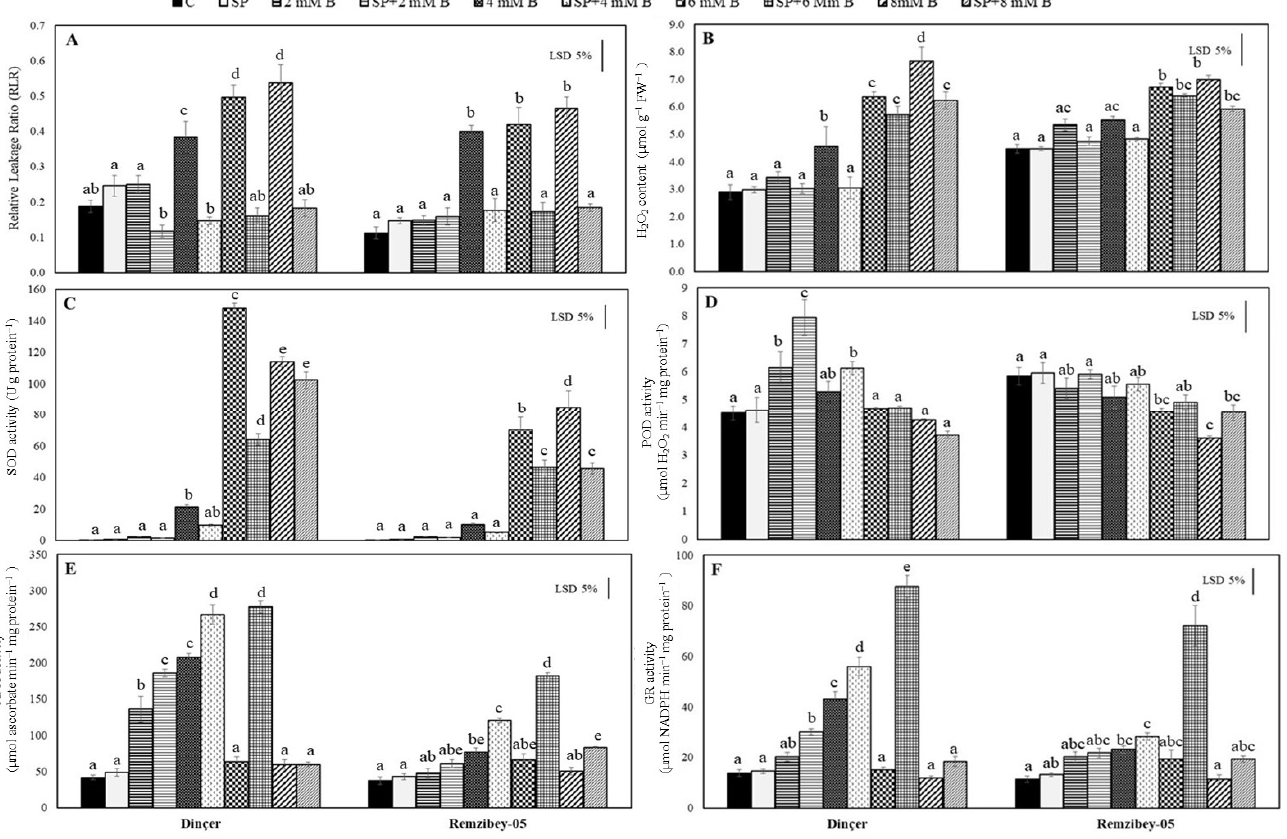
Figure 6. B treatments with or without SP induced changes of RLR ( A ), H 2 O 2 contents ( B ); and the activities of SOD ( C ), POD ( D ), APX ( E ), and GR ( F ) in the leaves of safflower cultivars. The values are presented as the mean ± standard error (SE), n = 3. The bars and different letters indicate significant difference between treatments and cultivars at p < 0.05 according to the LSD